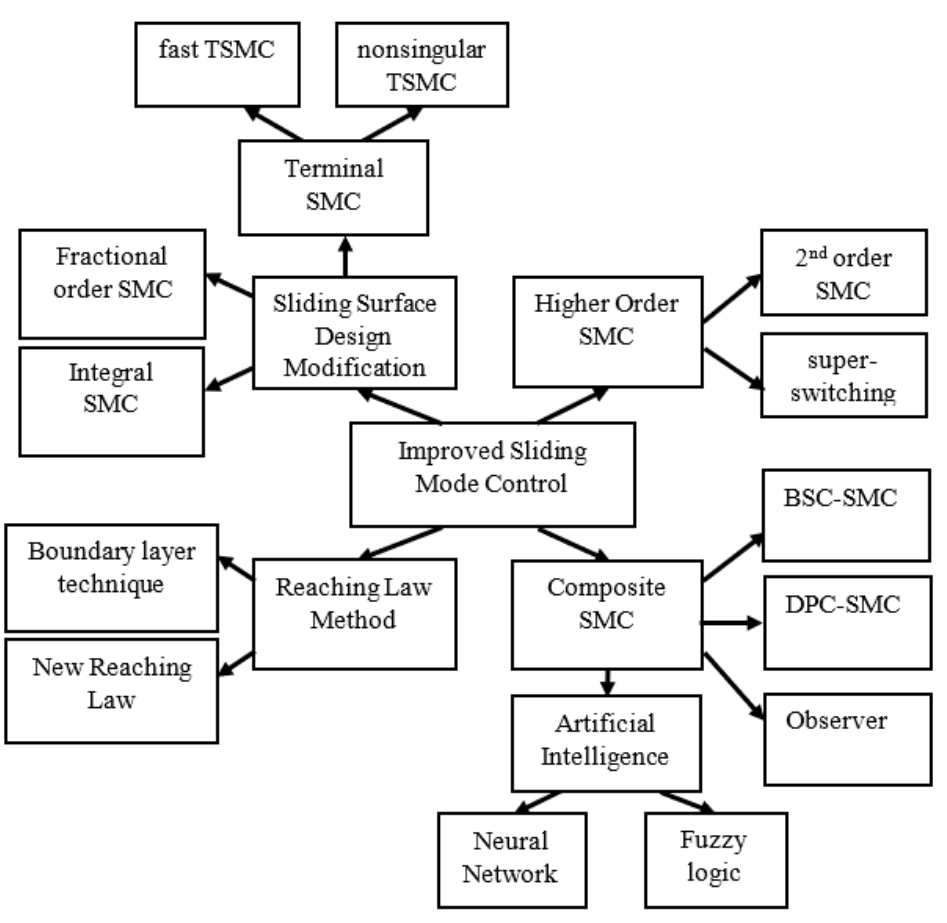
Figure 3. Summary of SMC enhancement techniques.